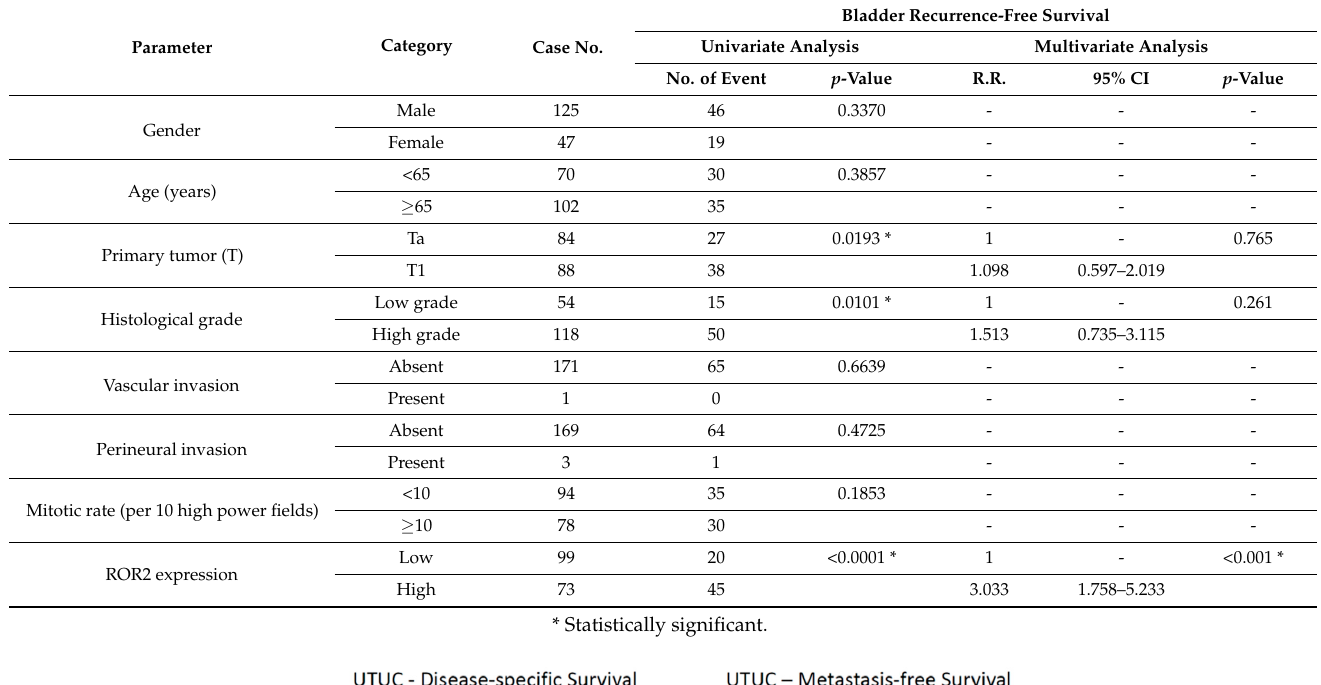
Table 5. Univariate log-rank and multivariate analyses for bladder recurrence-free survival in NMIBC post TURBT.